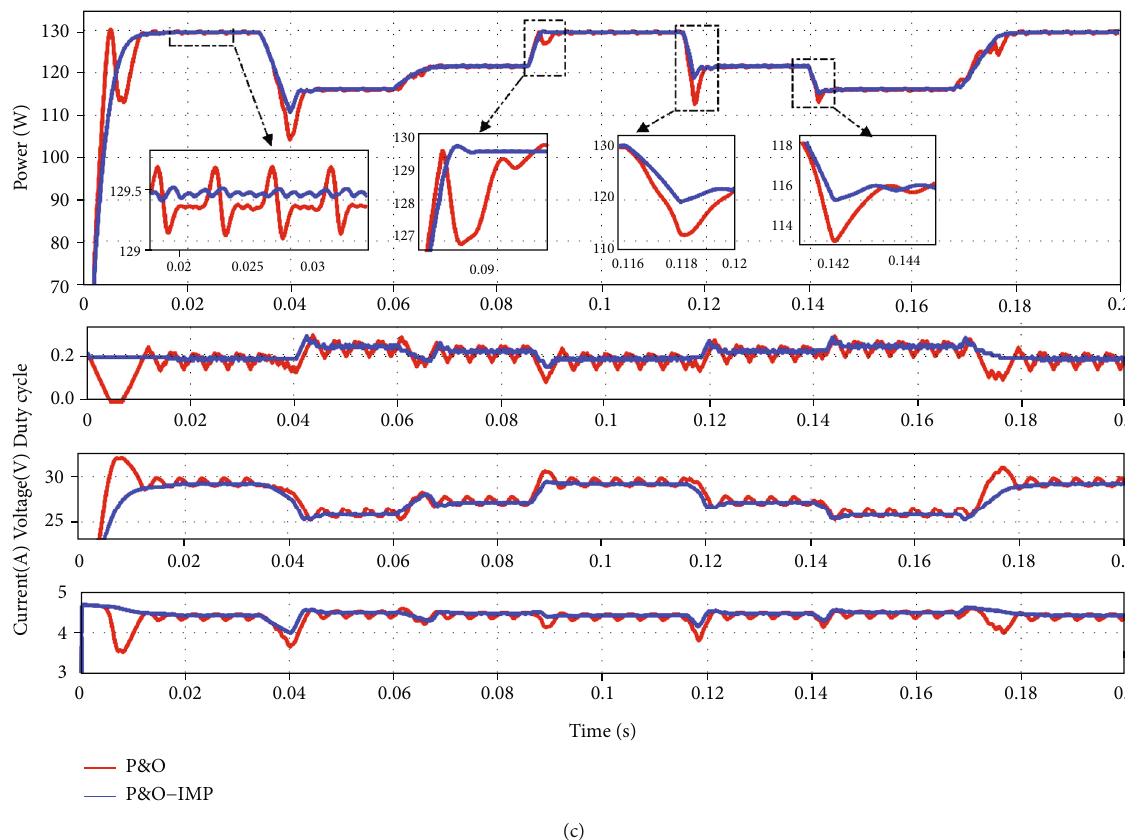
Figure 17: Simulation result comparison between the P&O method and the P&O-IMP method under the scenario of temperature variation with constant solar radiation: (a) 1000 W/m 2 ; (b) 800W/m 2 ; (c) 600W/m 2 .